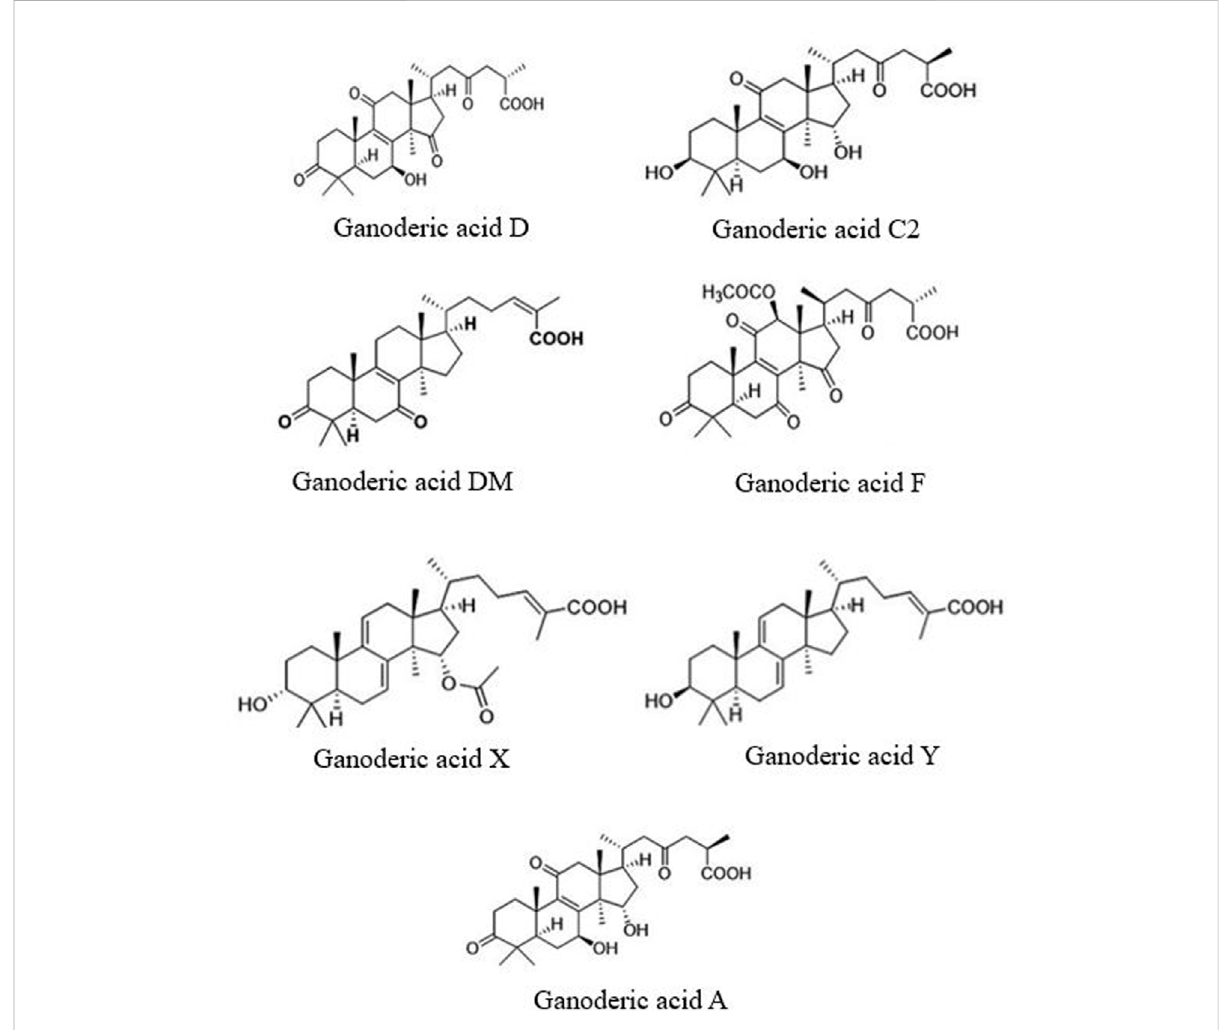
Structural formula of common Ganoderic acids found in Ganoderma lucidum